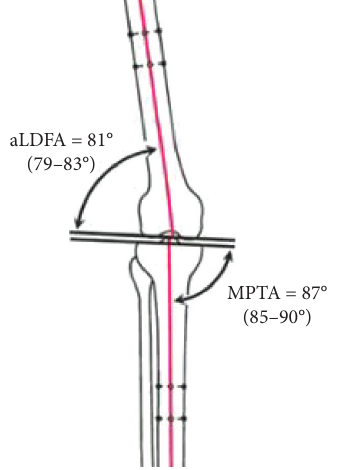
Figure 5: aLDFA and MPTA in normal knee